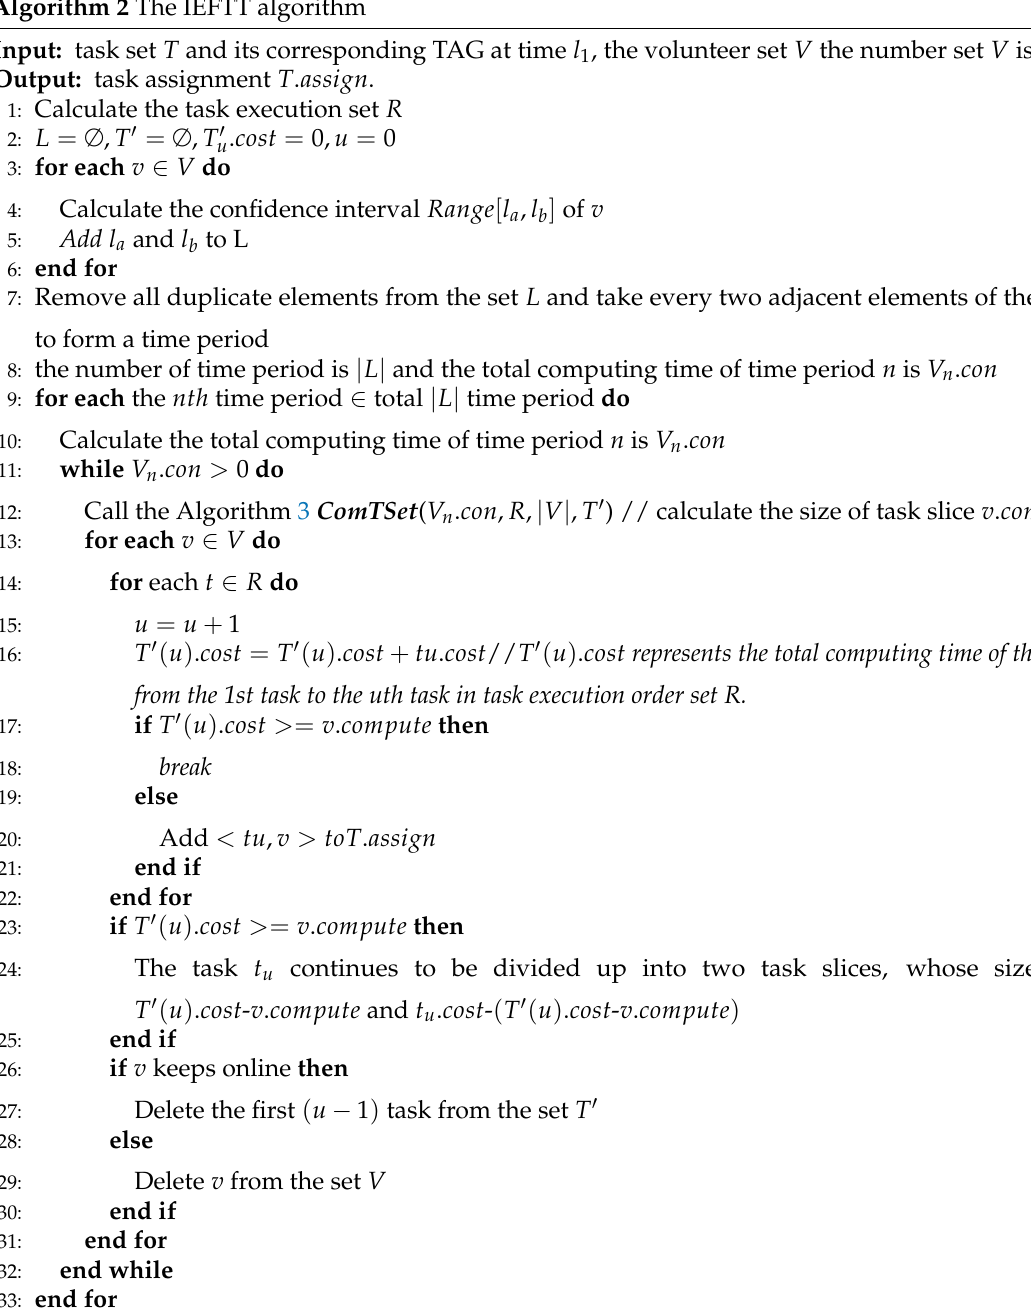
algorithm did not stop until that the task execution order set R was empty or the volunteer set V was empty. The IEFTT algorithm is described in detail in Algorithm 2. Algorithm 2 The IEFTT